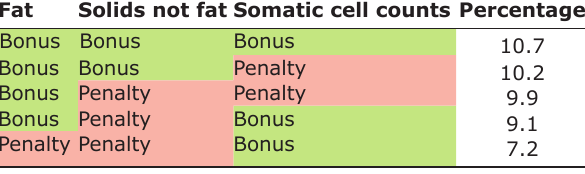
Green and red colors indicate bonus and penalty group, respectively Table-3: Primary patterns of payment classes and milk components in bulk tank milk from the northern region of Thailand.